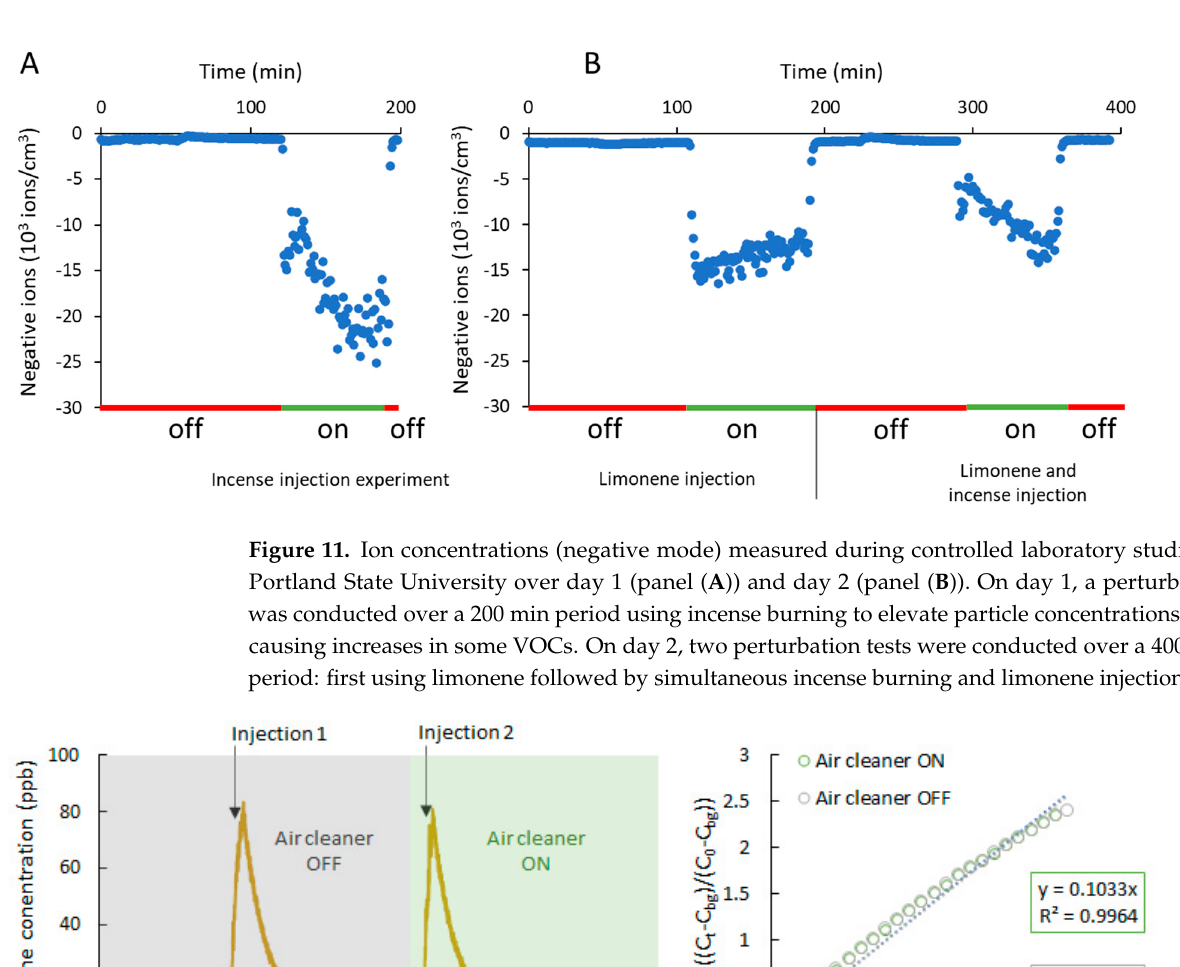
pass efficiency would meaningfully reduce concentrations of target pollutants in the